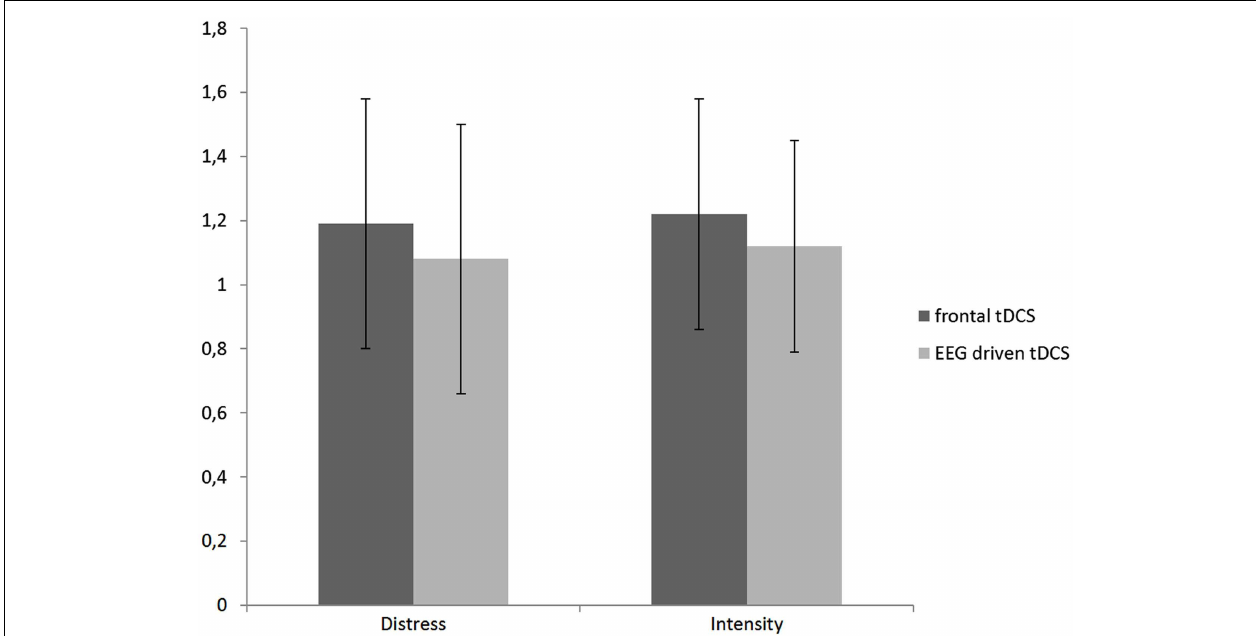
FIGURE 2 |A comparison between the obtained difference (Pre – Post tDCS) for the distress and intensity measurement in respectively frontal and EEG driven tDCS.